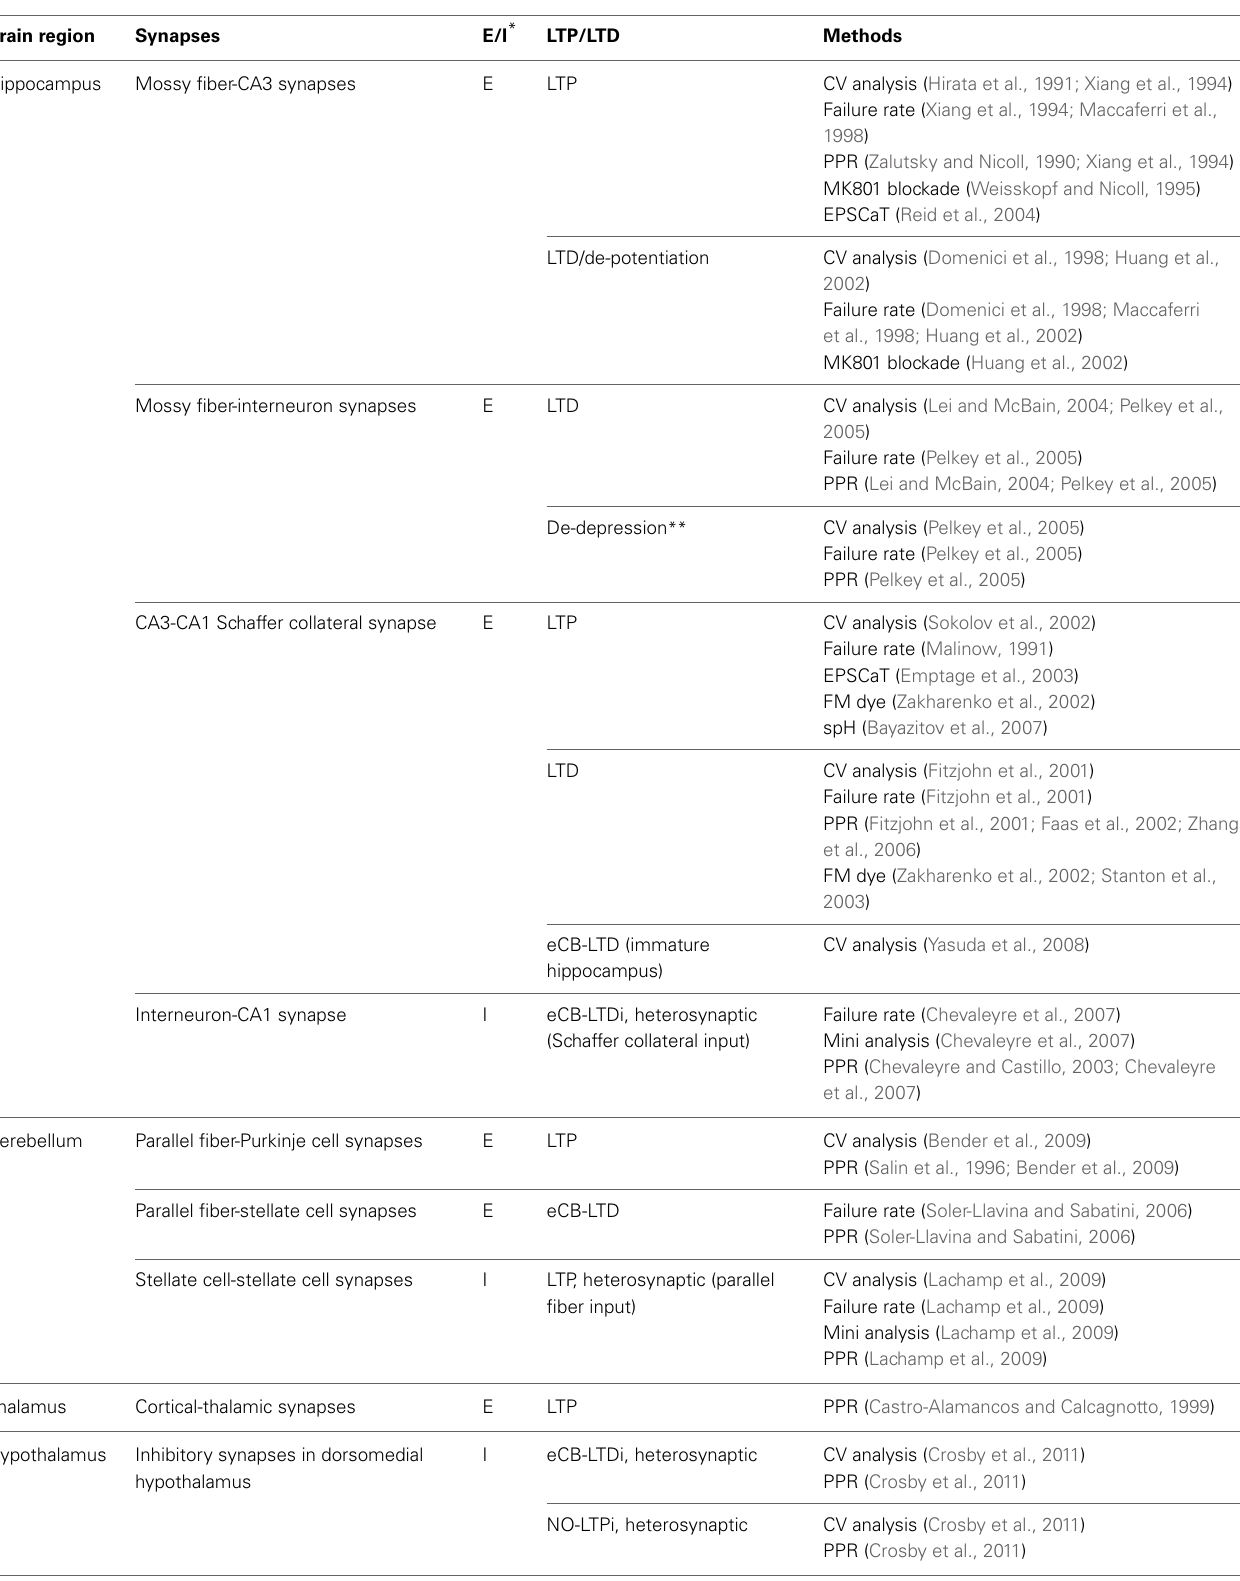
Table 1 | Presynaptic long-term plasticity is a widespread phenomenon in the brain. Brain